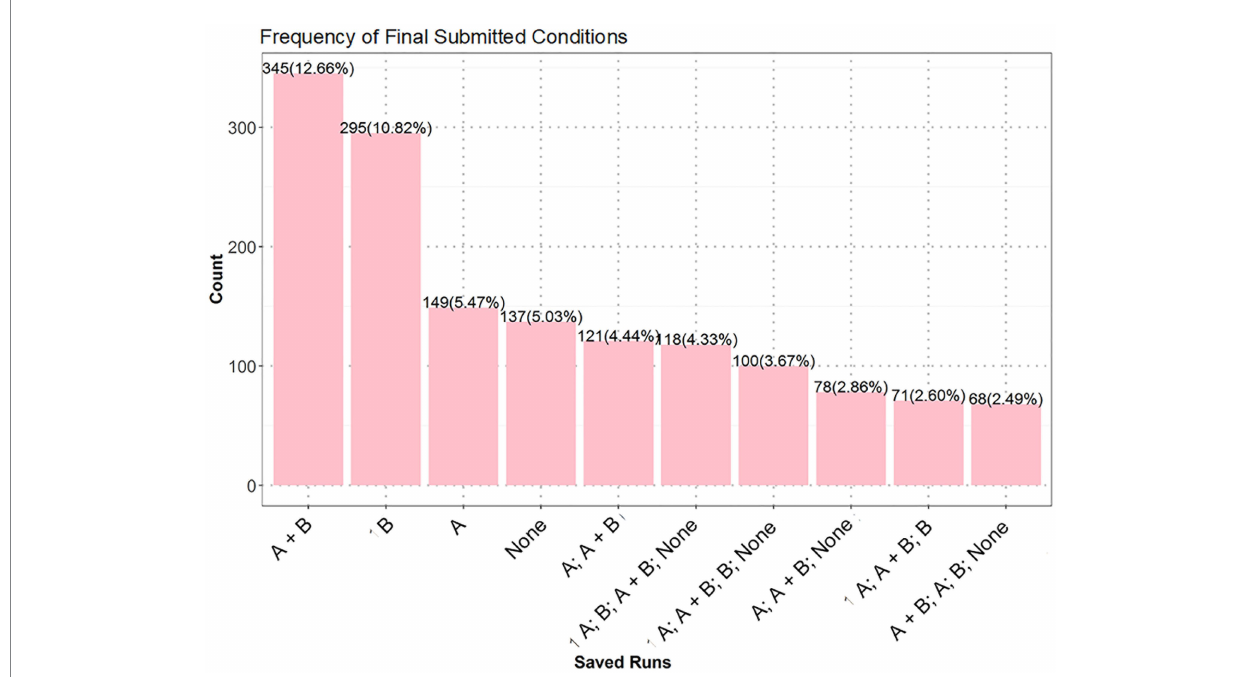
FIGURE 7 Top 10 frequent answers of the exhaustive test 1. Values on top of bars are numbers of students, and those inside brackets are percentages of students.